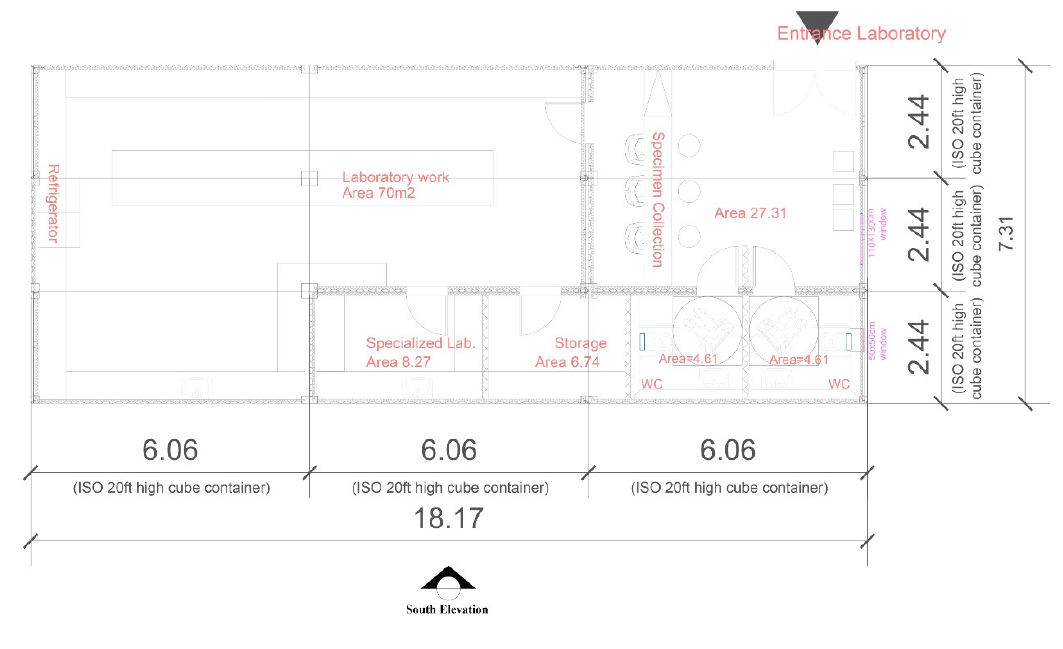
Figure A7. Endoscopy department plan of the relocatable hospital in Mosul.